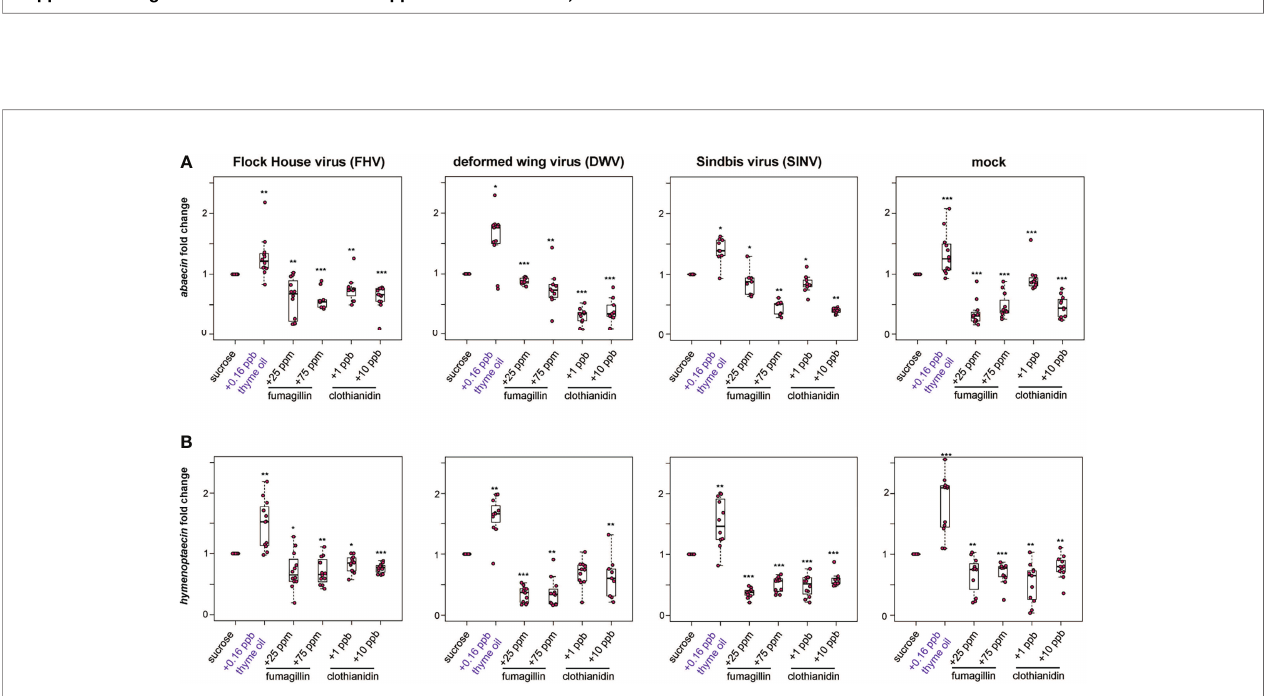
FIGURE 3 | Expression of key RNAi genes was higher in honey bees fed thyme oil augmented sucrose syrup and lower in bees fed sucrose syrup containing fumagillin or clothianidin. Expression of dicer-like and argonaute-2 in honey bees that were either mock- or virus-infected (i.e., FHV, DWV, SINV) and fed sucrose syrup only or syrup containing either thyme oil (0.16 ppb), fumagillin (25 ppm or 75 ppm), or clothianidin (1 ppb or 10 ppb) was assessed by qPCR. The DD Ct method with normalization to rpl8 in mock or virus-infected bees fed sucrose syrup diet was utilized to determine the relative gene expression. (A) Dicer-like ( dcr-like ) expression was higher in virus-infected (i.e., FHV, DWV, SINV) and mock-infected bees fed thyme oil containing sucrose syrup, and lower in bees fed sucrose syrup containing fumagillin (25 ppm or 75 ppm) or clothianidin (1 ppb or 10 ppb) relative to bees fed sucrose syrup. (B) Argonaute-2 ( ago2 ) expression was higher in virus infected (i.e., FHV, DWV, SINV) or mock-infected bees fed thyme oil augmented sucrose syrup and reduced in bees fed diets containing fumagillin (25 ppm or 75 ppm) or clothianidin (1 ppb or 10 ppb), except in mock-infected bees fed 75 ppm fumagillin, ago2 expression was similar to expression levels in bees fed sucrose only. Data were analyzed by a pairwise Wilcoxon Rank Sums with a Benjamini – Hochberg correction for multiple comparisons. Asterisks indicate a signi fi cant change in gene expression compared to sucrose only control; signi fi cance levels: * p < 0.05; ** p < 0.005; *** p < 0.0005. This fi gure shows representative biological replicate for each gene (i.e., rep2 for dcr-like and rep3 for ago2 ). The data for all three biological replicates are presented in Supplemental Figures S4, S5 . Raw data are included in Supplemental Tables S7 – S10